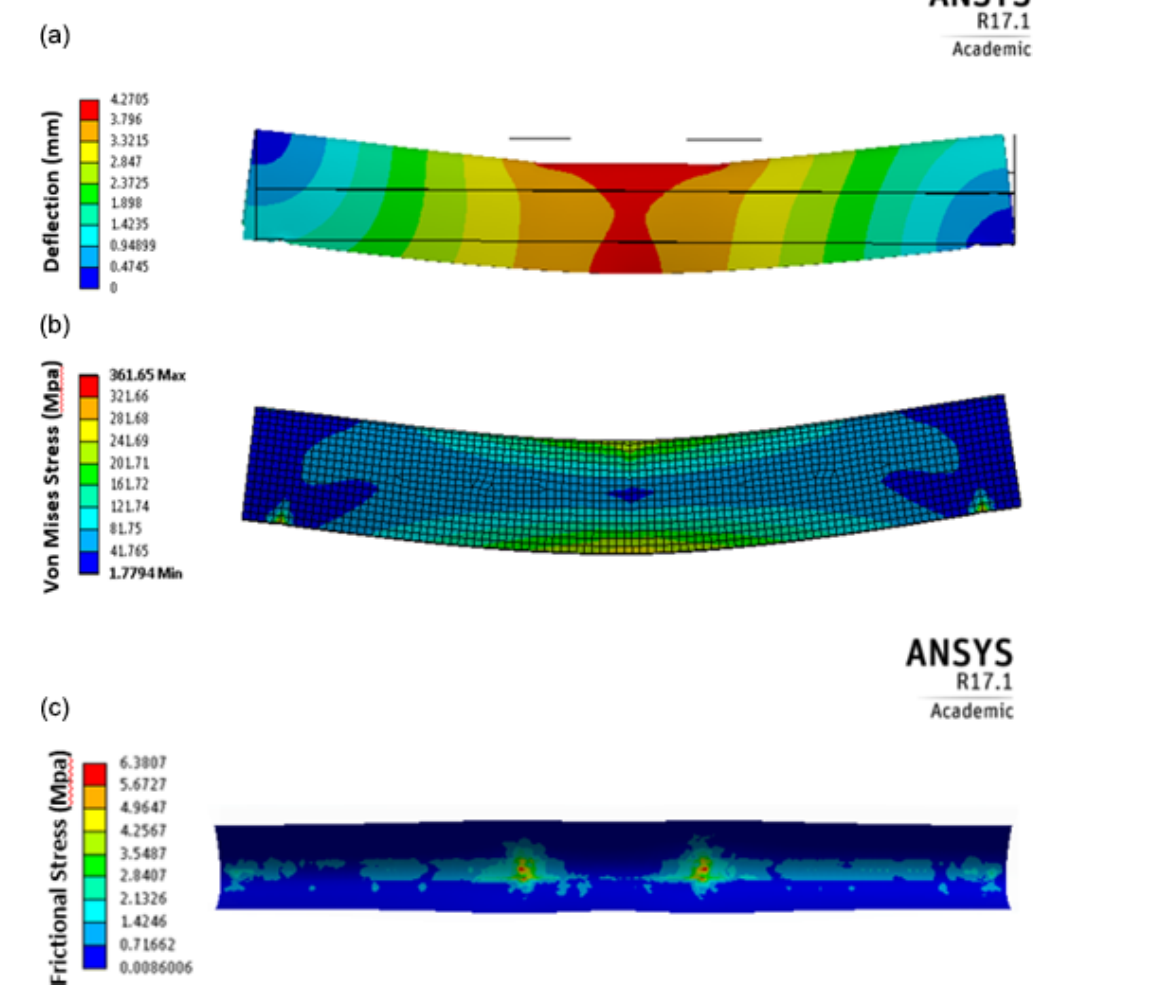
Figure 9. Contour plots showing the results from the FEA model when a loading of 40kN is applied to the demonstrator, where (a) is the deflection and von Mises (equivalent) stress and (b) is the frictional stress between the LEP and the blade